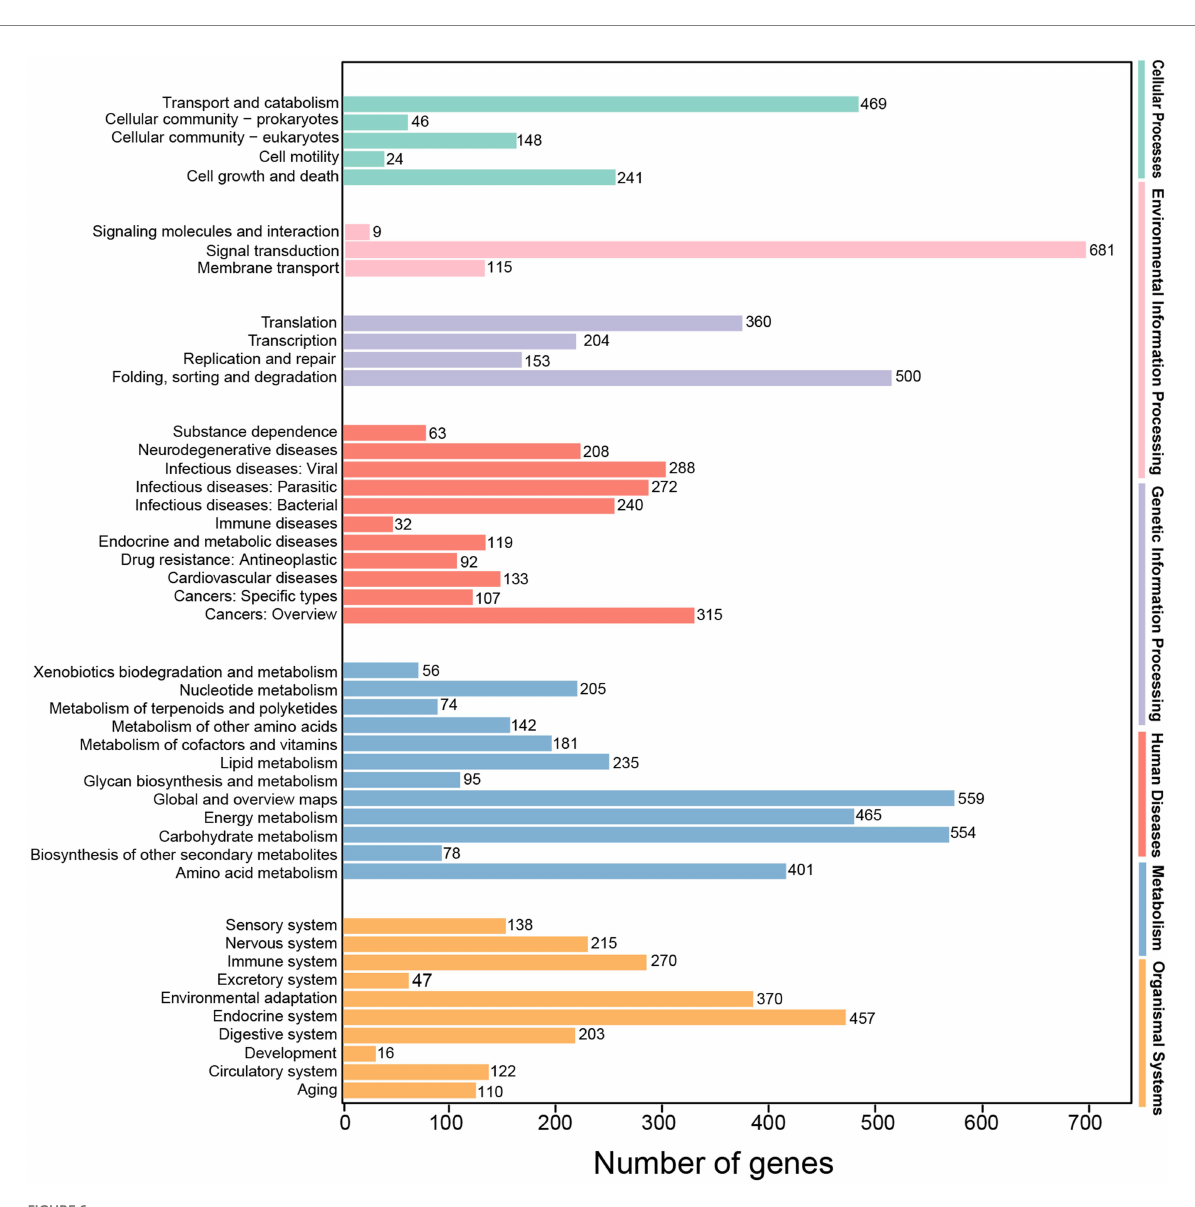
FIGURE 6 KEGG classification of high-quality transcripts of the A. sanguinea full-length